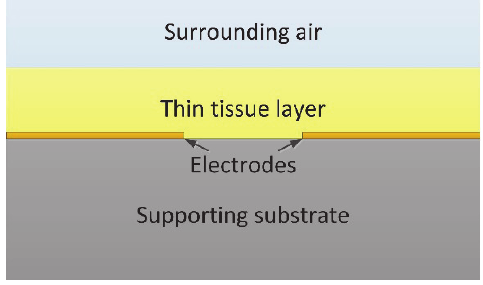
Fig. 5: The materials surrounding the conductivity